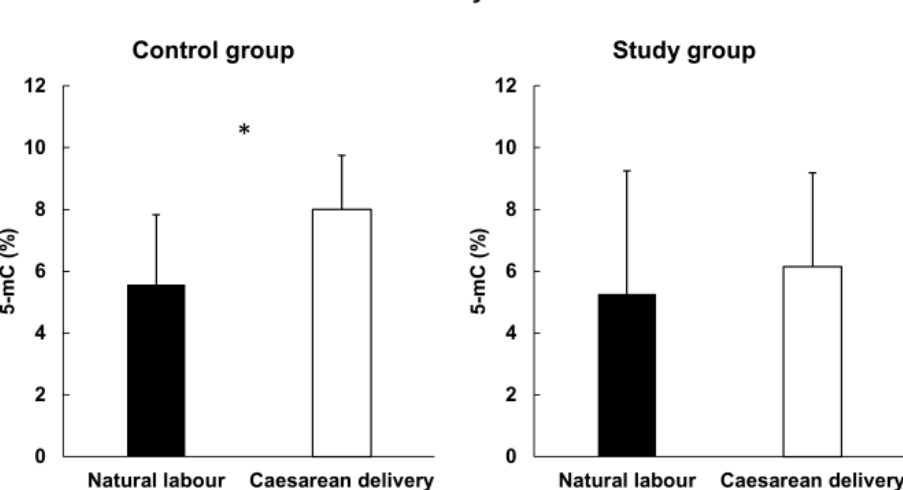
Figure 4. Global methylation level and type of delivery; *—statistically significant.